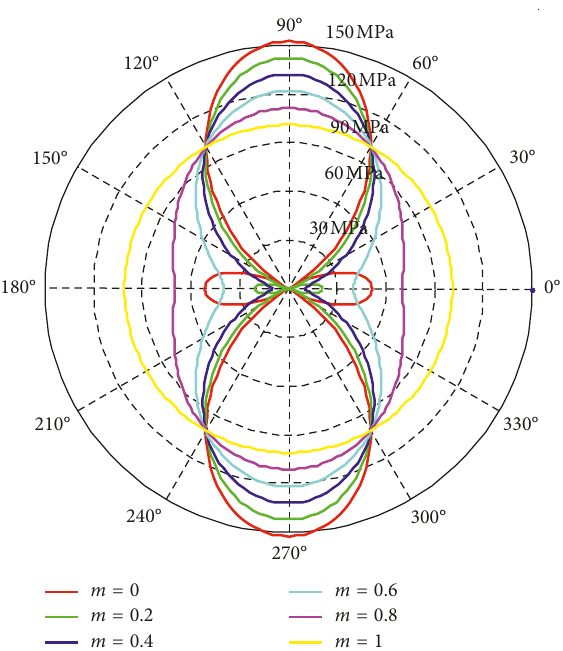
Figure 8: Circumferential stress curves around the hole corre- sponding to different m